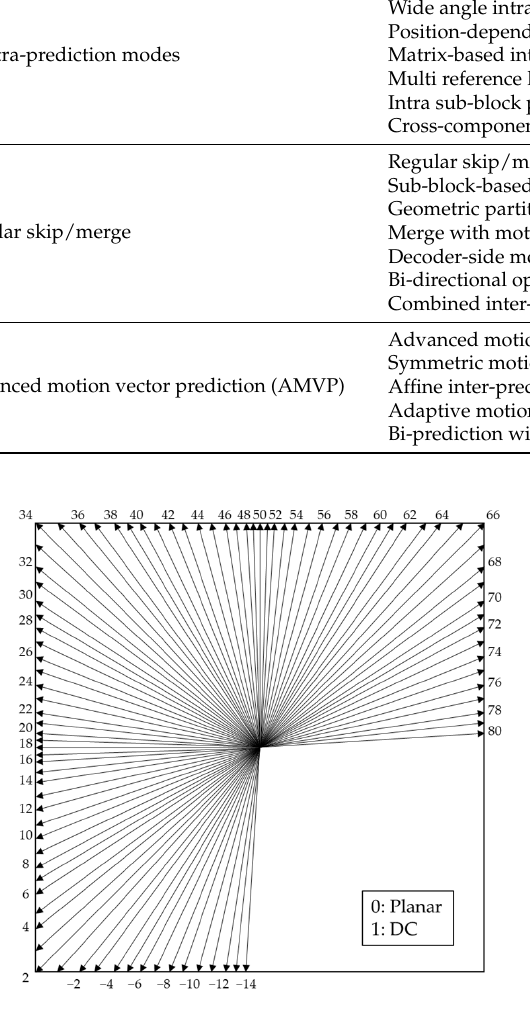
Figure 2. Intra-prediction modes in VVC. Inter-prediction fetches a predicted block from previously decoded reference frames using motion estimation (ME) and motion compensation (MC) processes. The motion parameter can be transmitted to the decoder in either an explicit or implicit manner. When a CU is coded as SKIP or MERGE mode, the encoder does not transmit any coding parameters, such as significant residual coefficients, motion vector differences, or a reference picture index. In cases of SKIP and MERGE modes, the motion information for the current CU is derived from the neighboring CUs including spatial and temporal candidates. VVC adopted several new coding tools for SKIP/MERGE and inter-prediction, such as affine inter prediction [12], geometric partitioning mode (GPM) [13], merge with motion vector difference (MMVD) [14], decoder-side motion vector refinement (DMVR) [15], combined inter- and intra-prediction (CIIP) [16], and bi-prediction with CU-level weight (BCW) [17]. VVC also adopted adaptive motion vector resolution (AMVR) [18], symmetric motion vector difference (SMVD) [19], and advanced motion vector prediction (AMVP) to save the bitrate of the motion parameters. Although these tools can significantly improve the coding performance, the computational complexity of a VVC encoder is up to nine times higher under the random-access (RA) configuration compared with that of HEVC